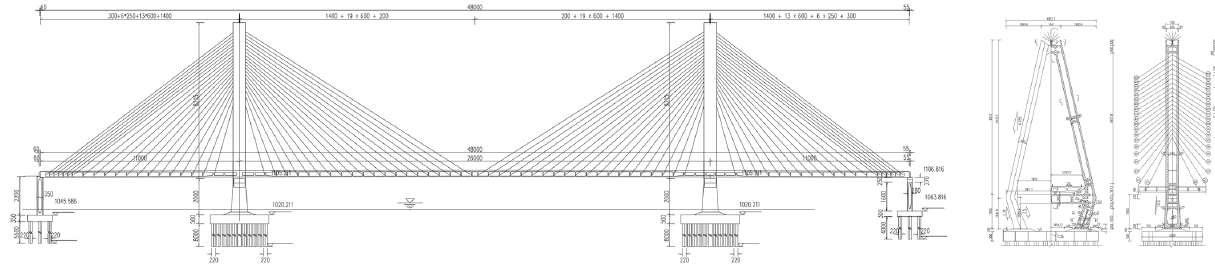
Figure 10. Bridge prototype (unit: mm).